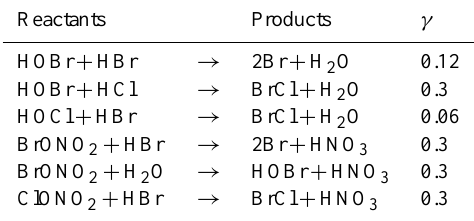
Table 2. Heterogeneous activation reactions of dissolved/adsorbed bromine species on liquid aerosols, NAT and ice particles in the full chemistry setup. Only the uptake coefficient γ for ice particle surfaces is given here, obtained from Sander et al. (2006). Reactants Products γ HOBr + HBr → 2Br + H 2 O 0.12 HOBr + HCl → BrCl + H 2 O 0.3 HOCl + HBr → BrCl + H 2 O 0.06 BrONO 2 + HBr → 2Br + HNO 3 0.3 BrONO 2 + H 2 O HOBr + HNO 3 0.3 BrCl + HNO 3